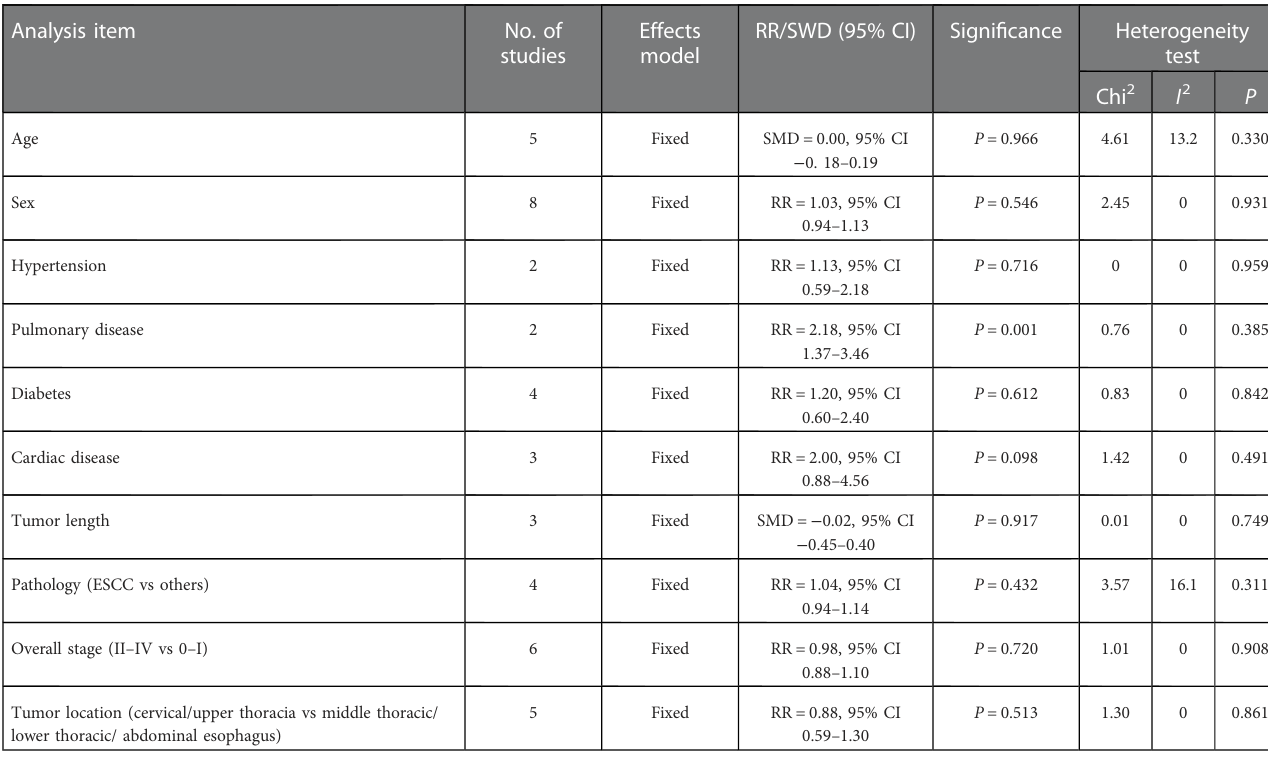
TABLE 2 Meta-analysis of clinical-pathological features. Analysis item